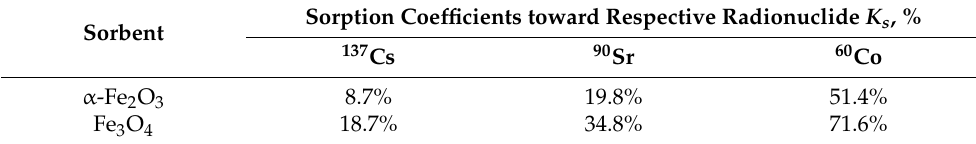
Table 1. Sorption effectiveness of investigated sorbents applied in drinking water.